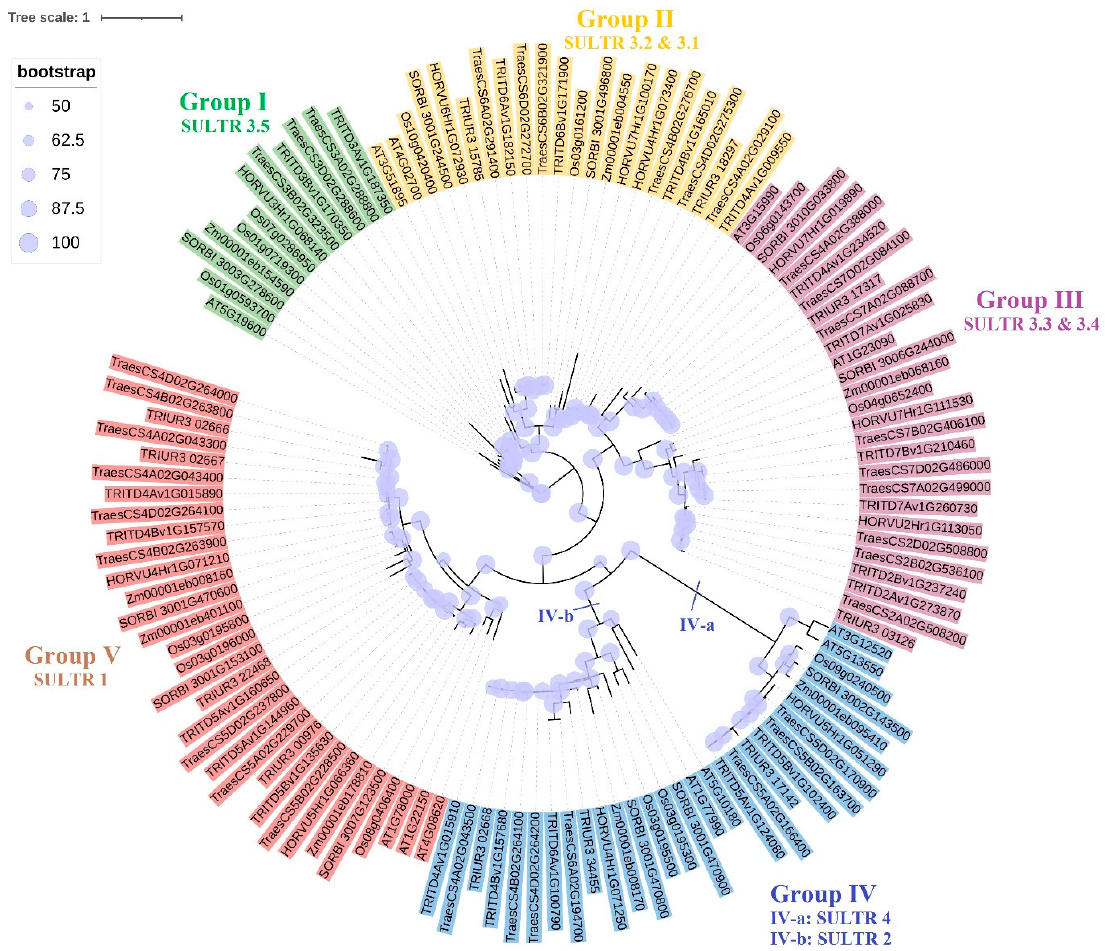
Figure 1. Phylogenetic analysis of SULTR gene family members from T. turgidum L. ssp. durum (Desf.) (TRITD prefix), T. aestivum (Traes prefix), T. uratu (TRIUR prefix), S. bicolor (SORBI prefix), H. vulgare (HORVU prefix), O. sativa (Os prefix), A. thaliana (AT prefix), and Z. mays (Zm prefix).